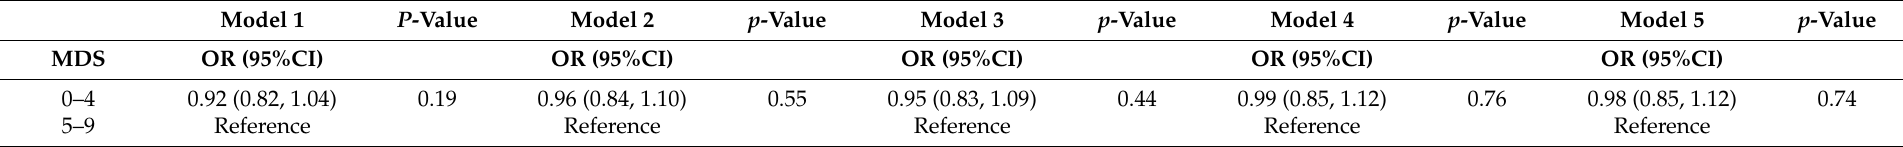
Table 2. Unadjusted and multivariable adjusted associations between low adherence MDS (scores 0–4 vs. 5–9) and weight related complications (EOSS 2–4 vs. 0–1) in the AHS 2011 to 2012 ( n = 5055).